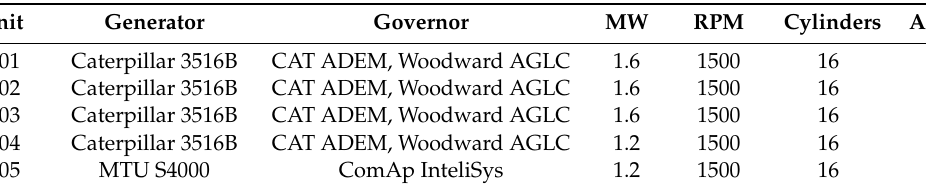
Table 3. King Island Currie Power Station generation.